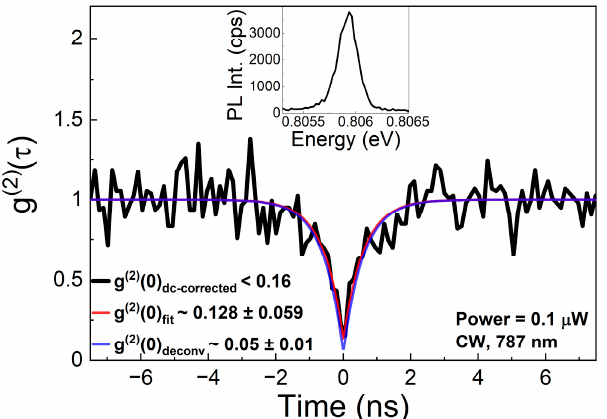
Figure 5. Second-order correlation function g (2) ( τ ) for CX emission under continuous-wave excitation after correction based on dark counts on detectors (black line), direct fit with the equation (2) (red line), and after the histogram deconvolution with the setup response function (blue line). Inset: corresponding μ PL spectrum from the correlation setup for the excitation power of 0.1 μ W.